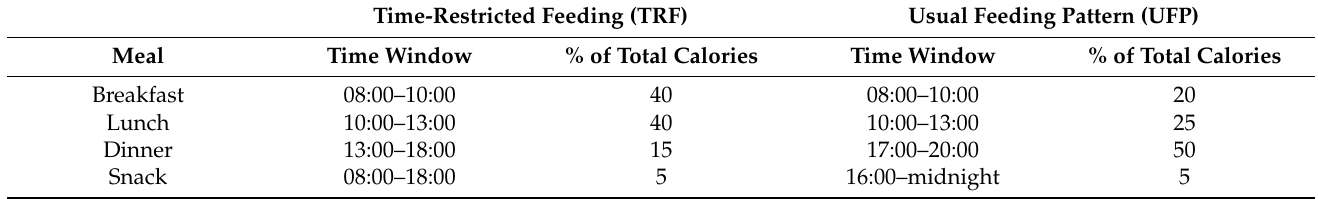
Table A1. Feeding windows and distribution of calories by study arm.